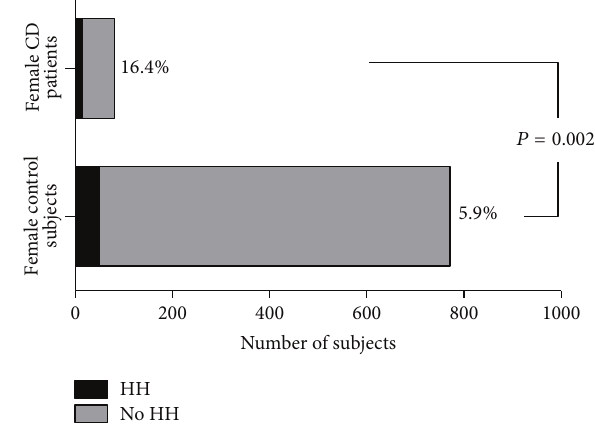
Figure 1: Prevalence of hepatic hemangioma (HH) in female CD patients and in female control subjects. 𝑦 -axis: female control subjects and female CD patients; 𝑥 -axis: number of